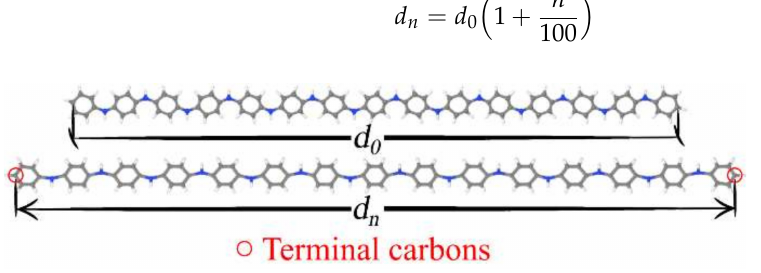
Figure 2. Illustration of the polymer chain deformation process (example for